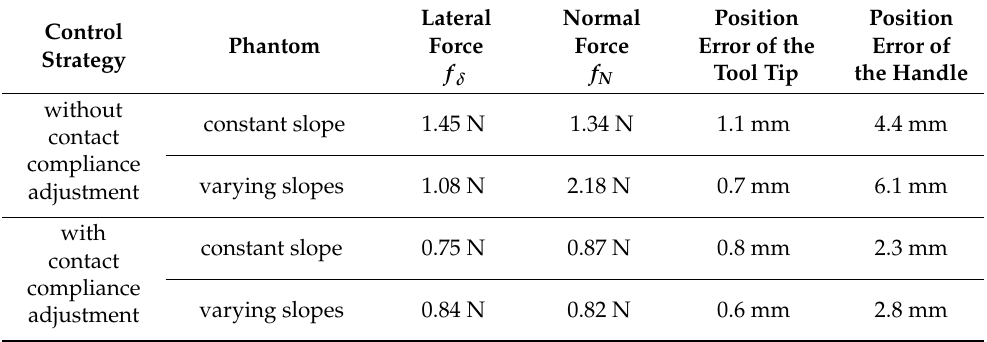
Table 1. Comparison of the contact forces and position errors of the tool under resolved motion rate control with/without contact compliance